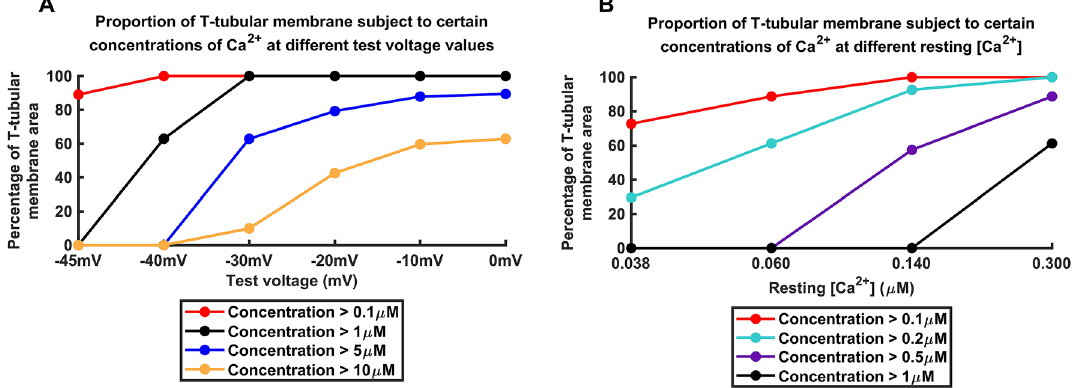
Figure 8. Proportions of T-SR junction T-tubular membrane area exposed to varied tested microdomain [Ca 2+ ]. Results shown for ( A ) active muscle at different test voltages (Fig. 3) and ( B ) resting (Fig. 7) skeletal muscle using previously modelled resting [Ca 2+ ]